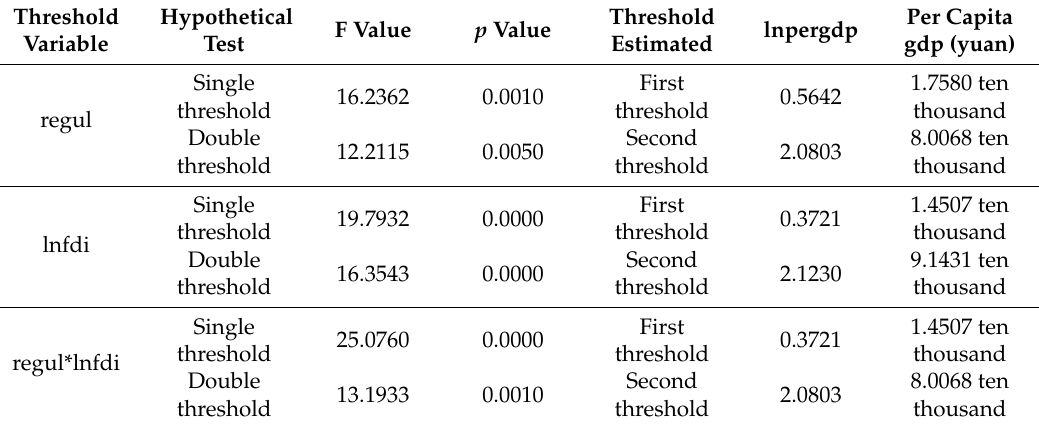
Table 3. Results of threshold conditions test and double threshold estimated value.